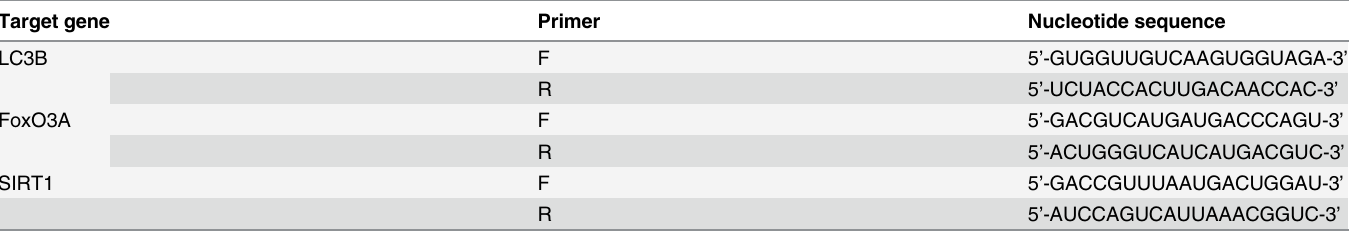
Table 2. Sequences of small interfering RNA used in